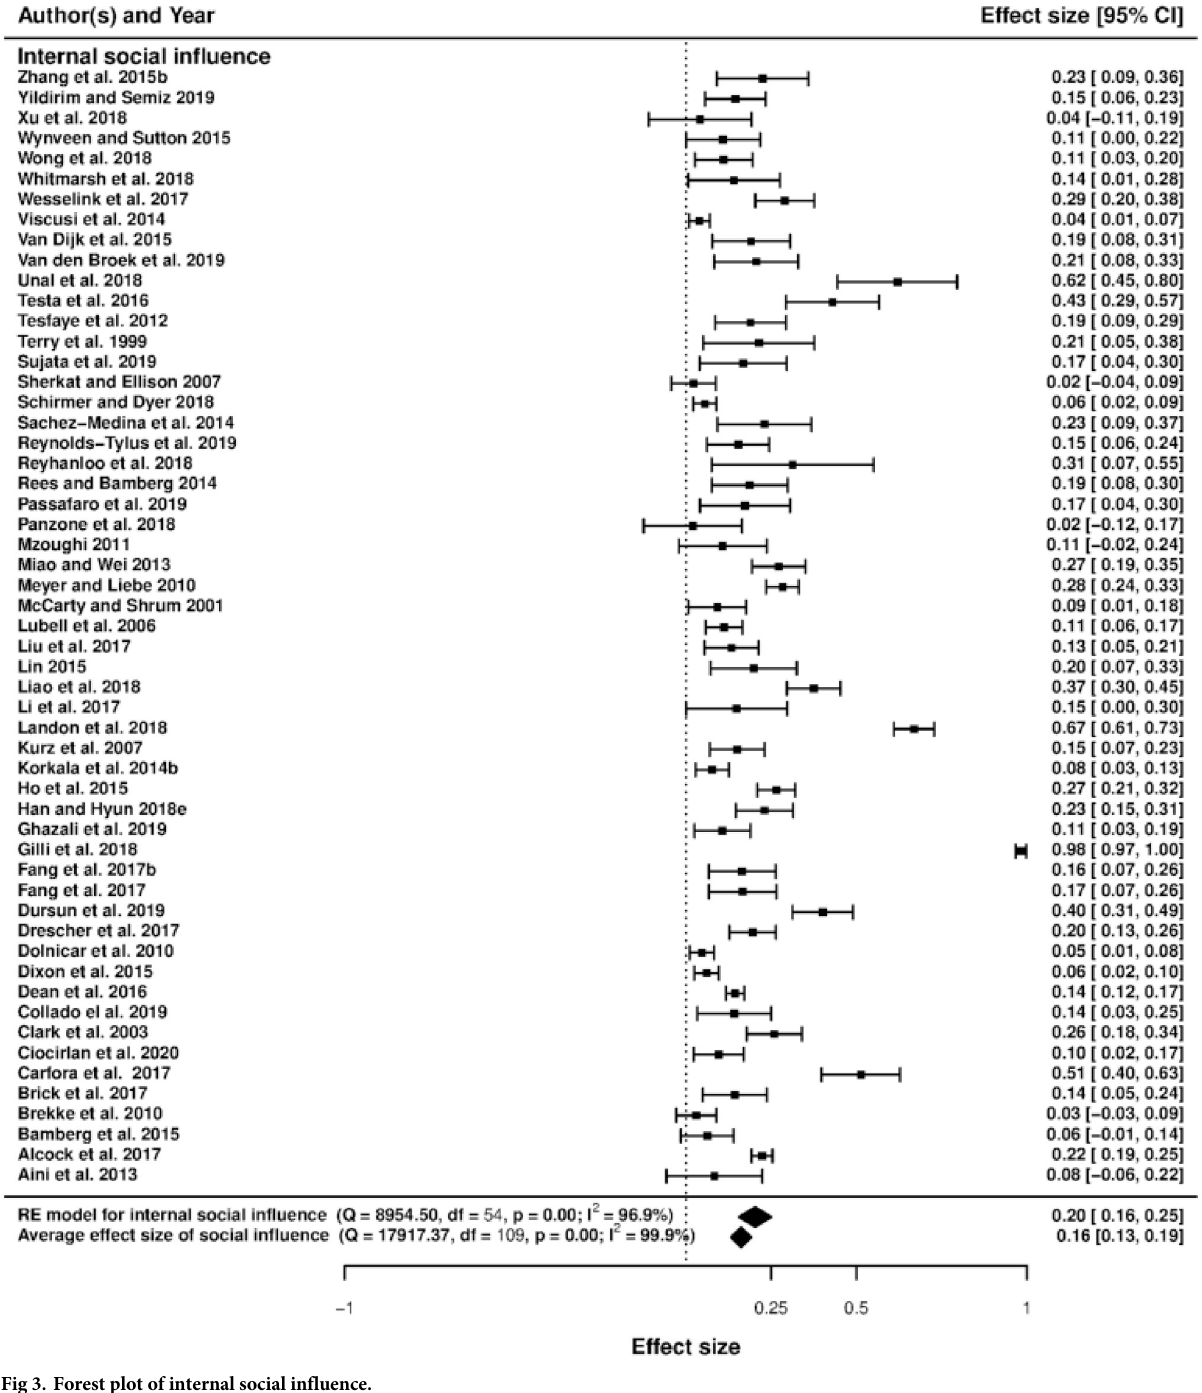
Fig 3. Forest plot of internal social